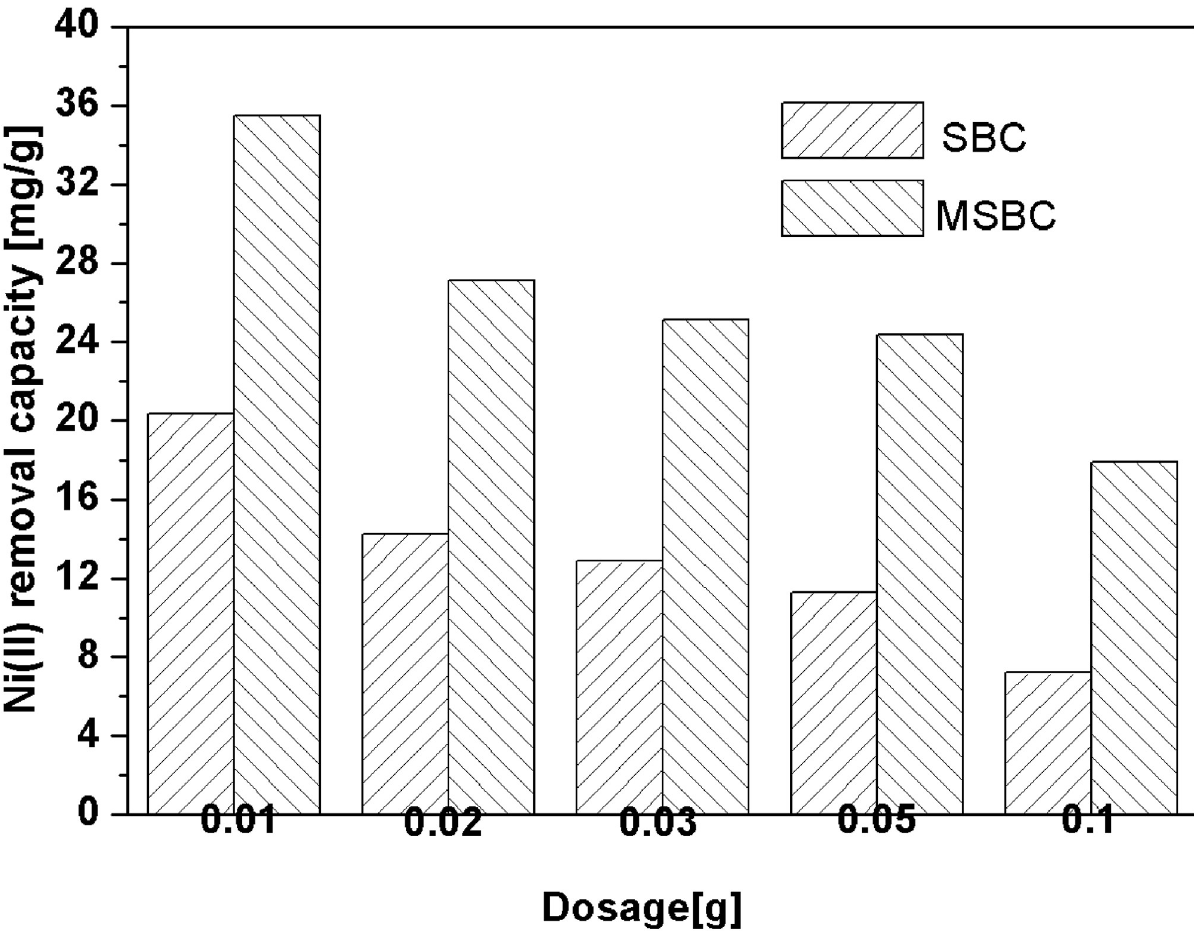
Fig 2. Comparison of SBC and MSBC adsorption capacities with various doses for Ni removal. Reaction conditions: Initial concentration of Ni(II) 100 ppm at pH 7, 50 ml of solution, 1~100 mg of biochar, 24 h, 25 ˚C.